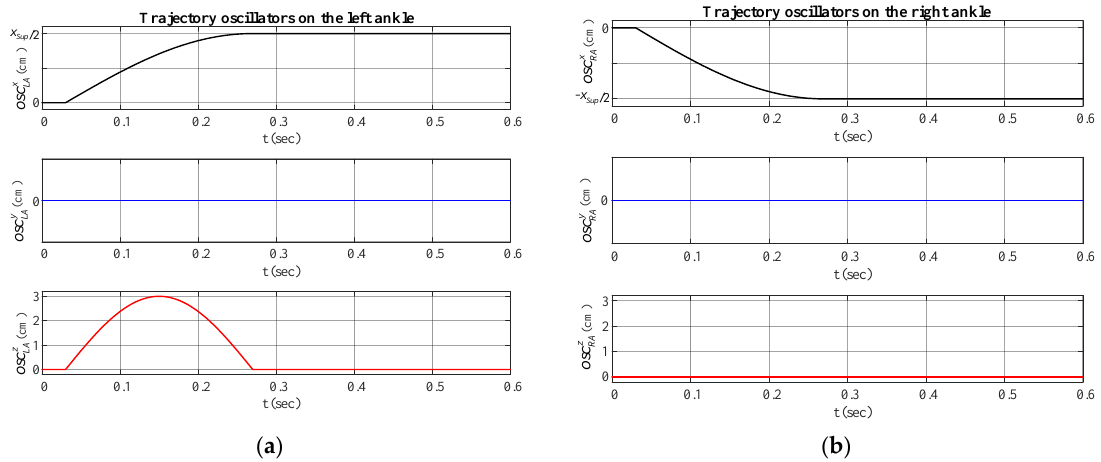
Figure 10. The stepping trajectories of the forward balance strategy. ( a ) Trajectory oscillators on the left ankle. ( b ) Trajectory oscillators on the right ankle.